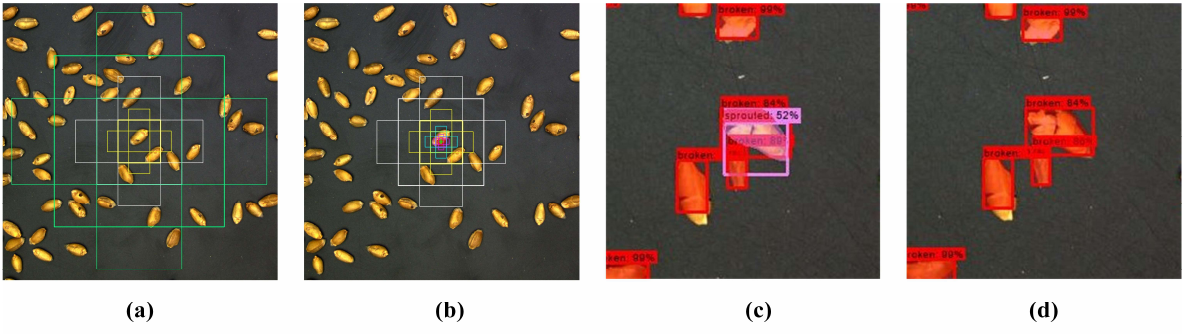
Figure 6. Comparison of RPN before and after lifting. ( a ) Anchor boxes before adjustment. ( b ) Anchor boxes after adjustment. ( c ) Image result before adjusting the NMS threshold. ( d ) Image result after adjusting the NMS threshold.